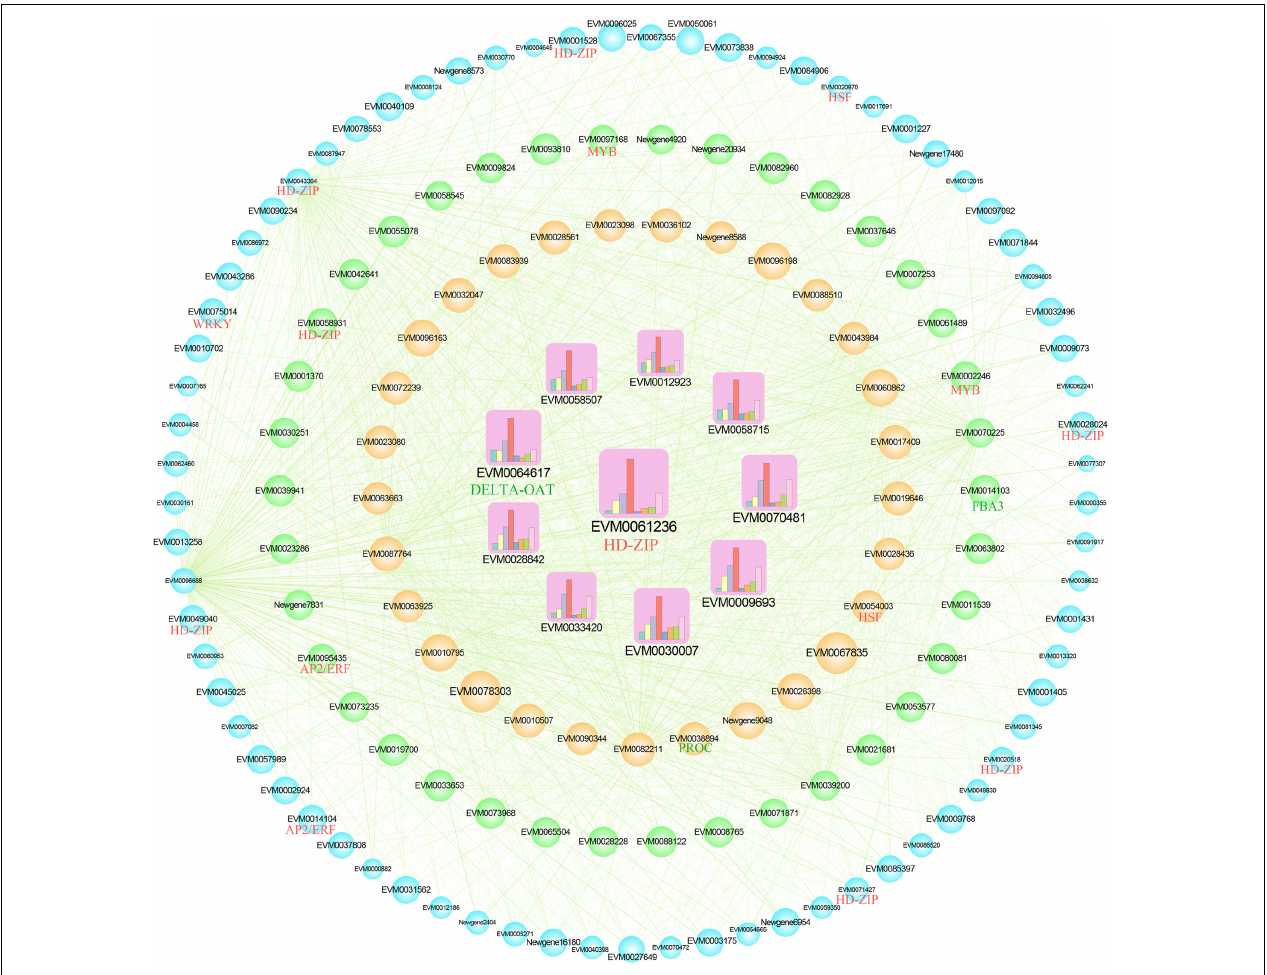
FIGURE 5 | Co-expression network of the core 150 genes in the green module. The 10 hub genes are showed as squares with inner column chart of gene expression level. The other genes were illustrated as circles. The size of the shape represents the degree of connectivity. The green lines indicate significant correlations ( r > 0.65). The transcription factor (TF) genes are labeled as red, and the structure genes annotated in the amino acid biosynthesis pathway are labeled as green. FBA3, fructose-bisphosphate aldolase 3; DELTA-OAT, ornithine aminotransferase; PROC, pyrroline-5-carboxylate